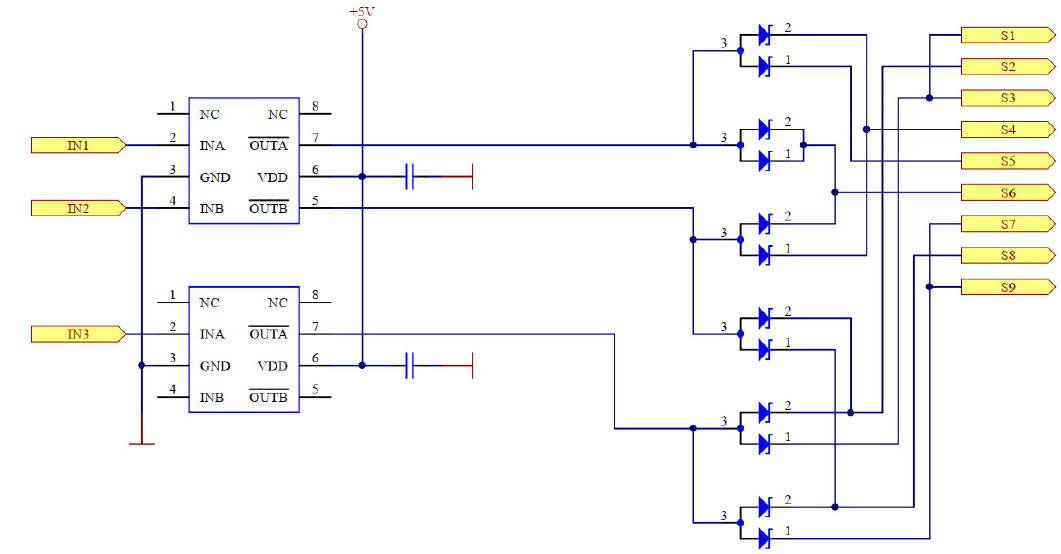
Figure 7. Separation of the control signals by a diode matrix .